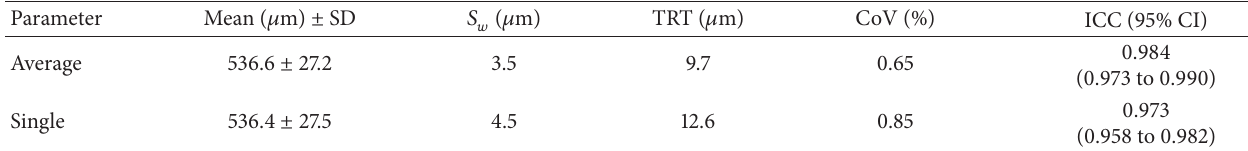
Table 2: Interobserver reproducibility of central corneal thickness readings using average (from average of 3 consecutive readings from each observer) and single (from the first reading from each observer) measurement by the corneal dynamic Scheimpflug analyzer Corvis ST. Parameter Mean ( 𝜇 m) ± SD 𝑆 𝑤 ( 𝜇 m) Average